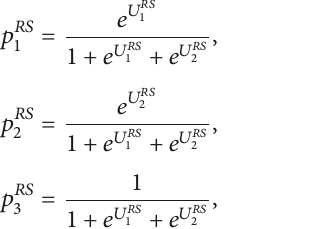
road network can be obtained according to (8) ∼ (9).